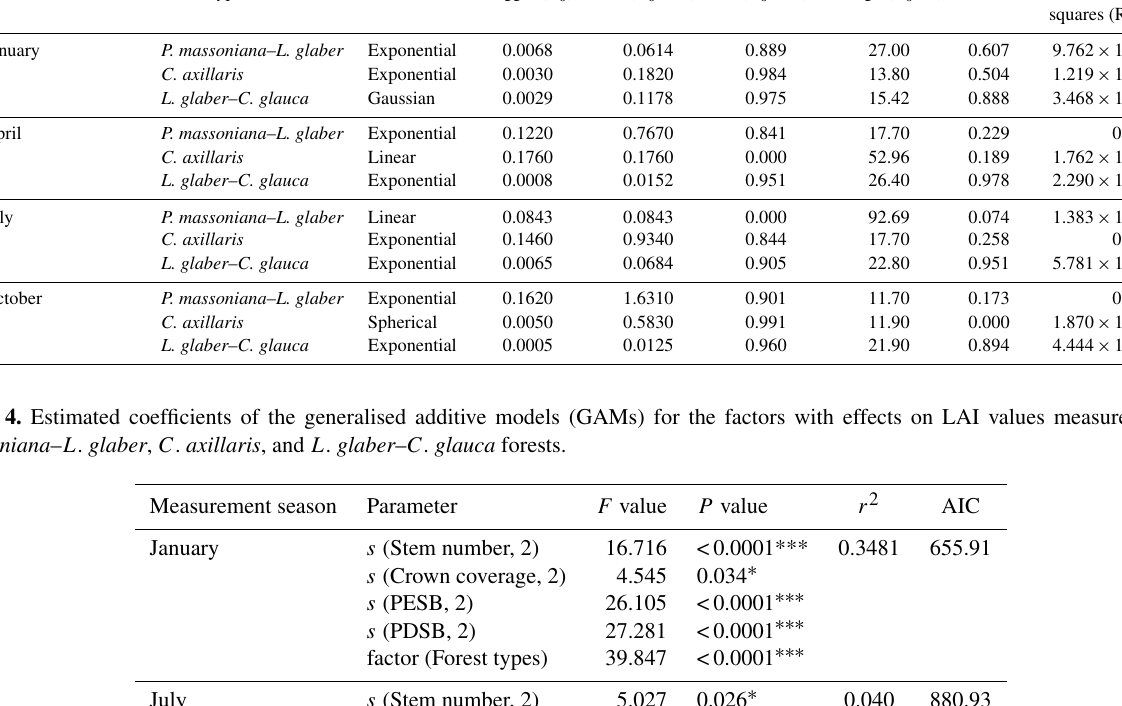
Table 3. Semivariogram theoretical models and fitted parameters for LAI values in P . massoniana – L . glaber (90m × 190m irregular shape), C . axillaris (100m × 100m), and L . glaber – C . glauca (100m × 100m) forests. Measurement season Forest type